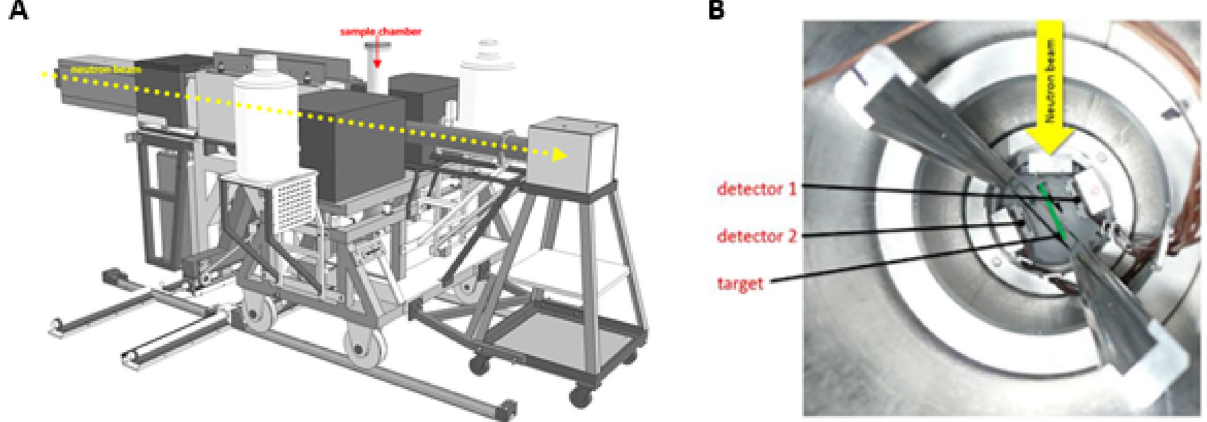
Figure 8. Prompt Gamma Activation Analysis (PGAA): ( A ) schematic overview; ( B ) sample chamber.